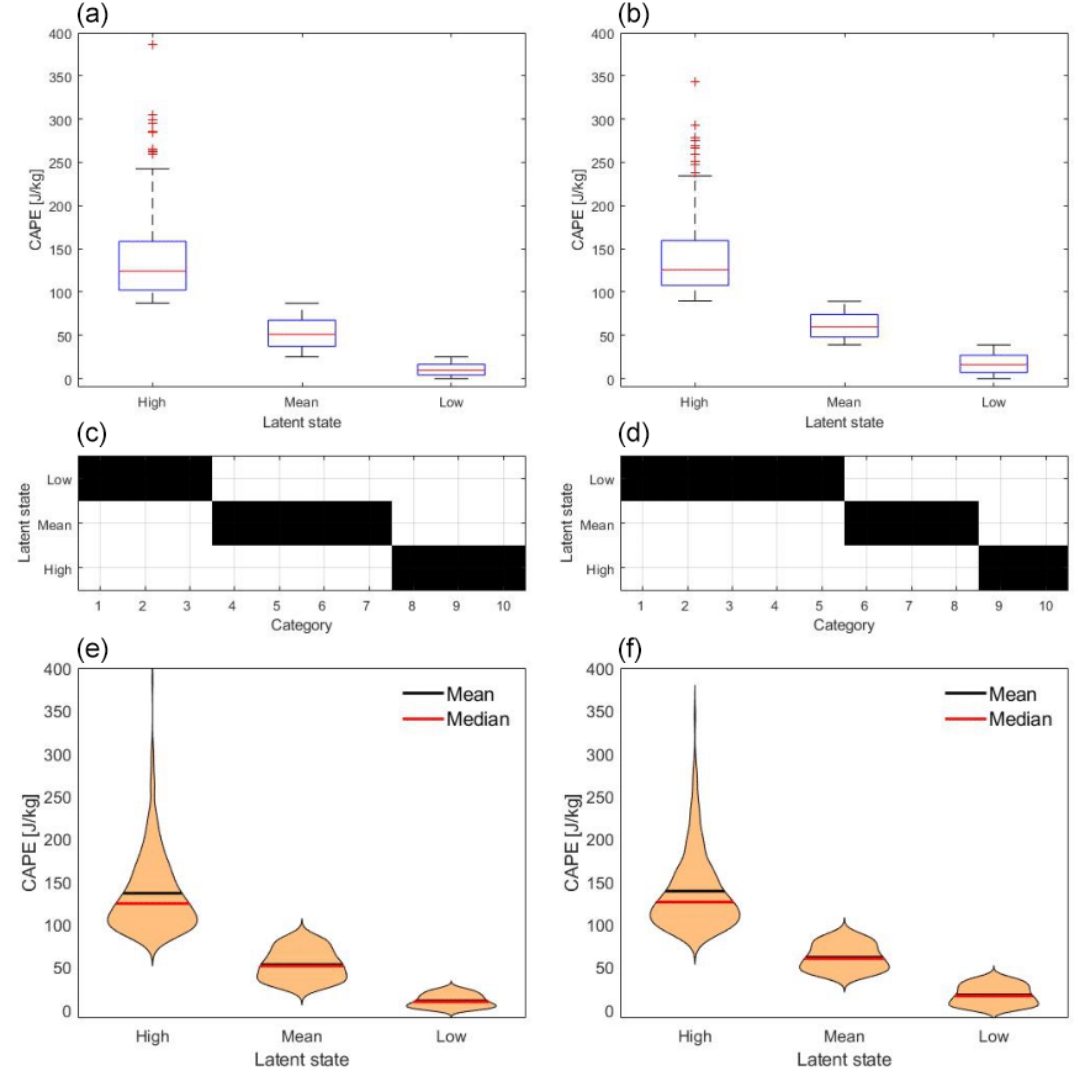
Figure A1. Box plots show the 12h averaged CAPE data which are affiliated to the high, mean, and low latent states. Panel (a) presents day data and panel (b) the night data. (c, d) Affiliation of CAPE categories to the latent states. (e, f) Distribution of CAPE in terms of latent states based on kernel density estimation. CAPE data are spatially averaged over the northwest quadrant of the COSMO-REA6 data, and the vertical velocity is averaged for a box discretization of 64 grid boxes; see Table